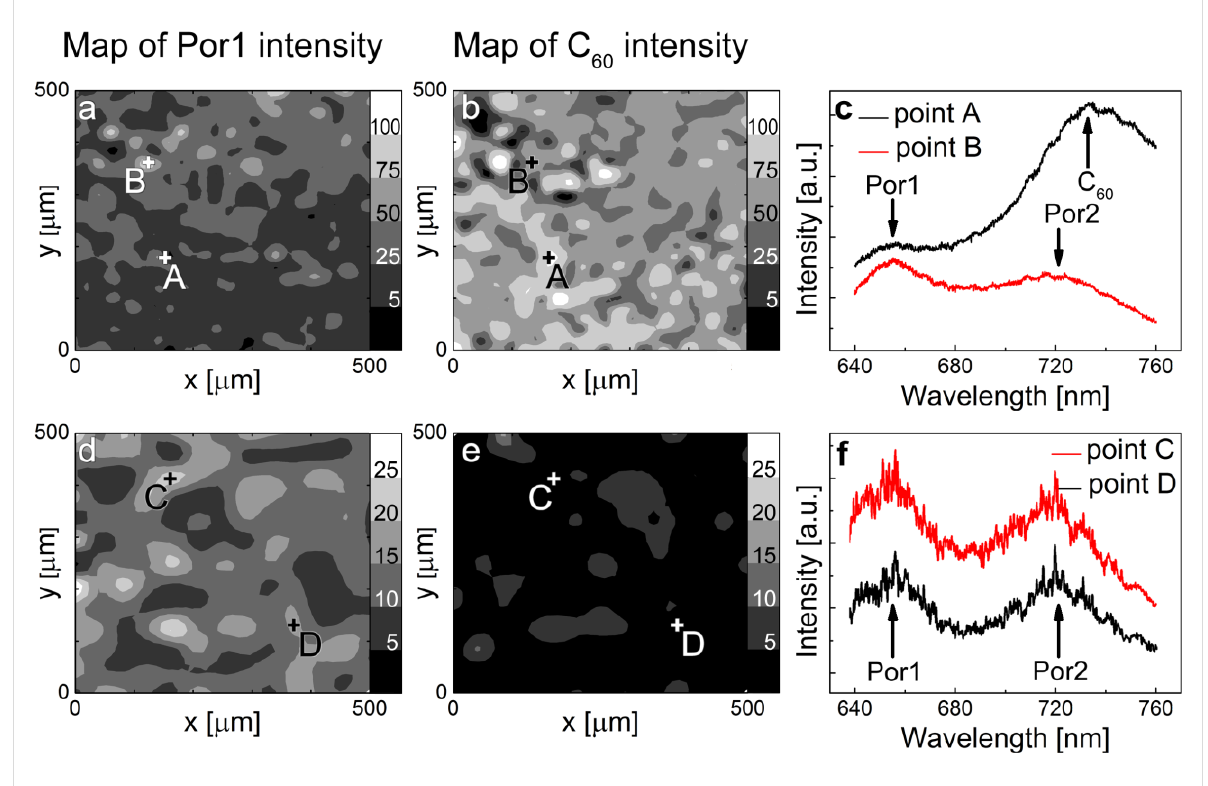
Figure 5: Fluorescence emission spectroscopy maps over 0.25 mm 2 (excitation wavelength = 532 nm) and selected spectra of transferred poly- merised TBPP-Zn networks before (a–c) and after (d–f) thermal desorption of the fullerene layer.